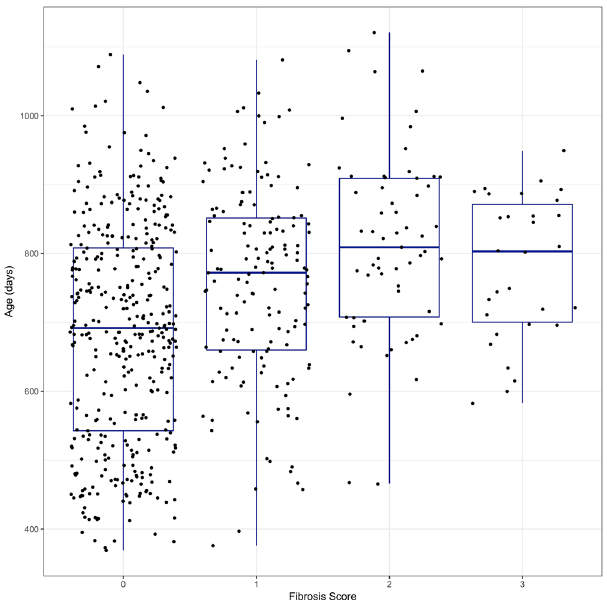
Figure 3. Distribution of cattle age at slaughter by fibrosis score. Figure shows box plots and actual values of cattle age at slaughter for each fibrosis score (n = 619). There is a positive age trend as fibrosis score increases from 0 to 3, but there is great variability of age values for each